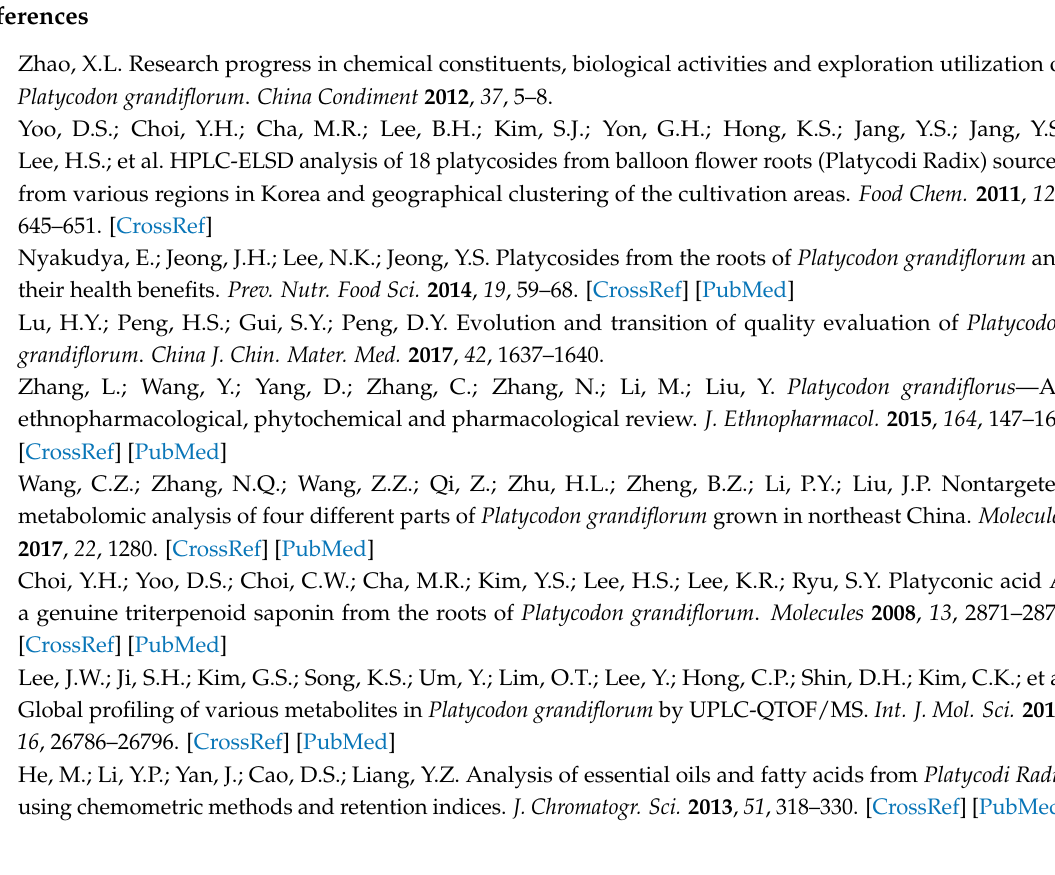
Supplementary Materials: The following are available, Table S1: Contents (mg/g) of 8 types of saponins in 89